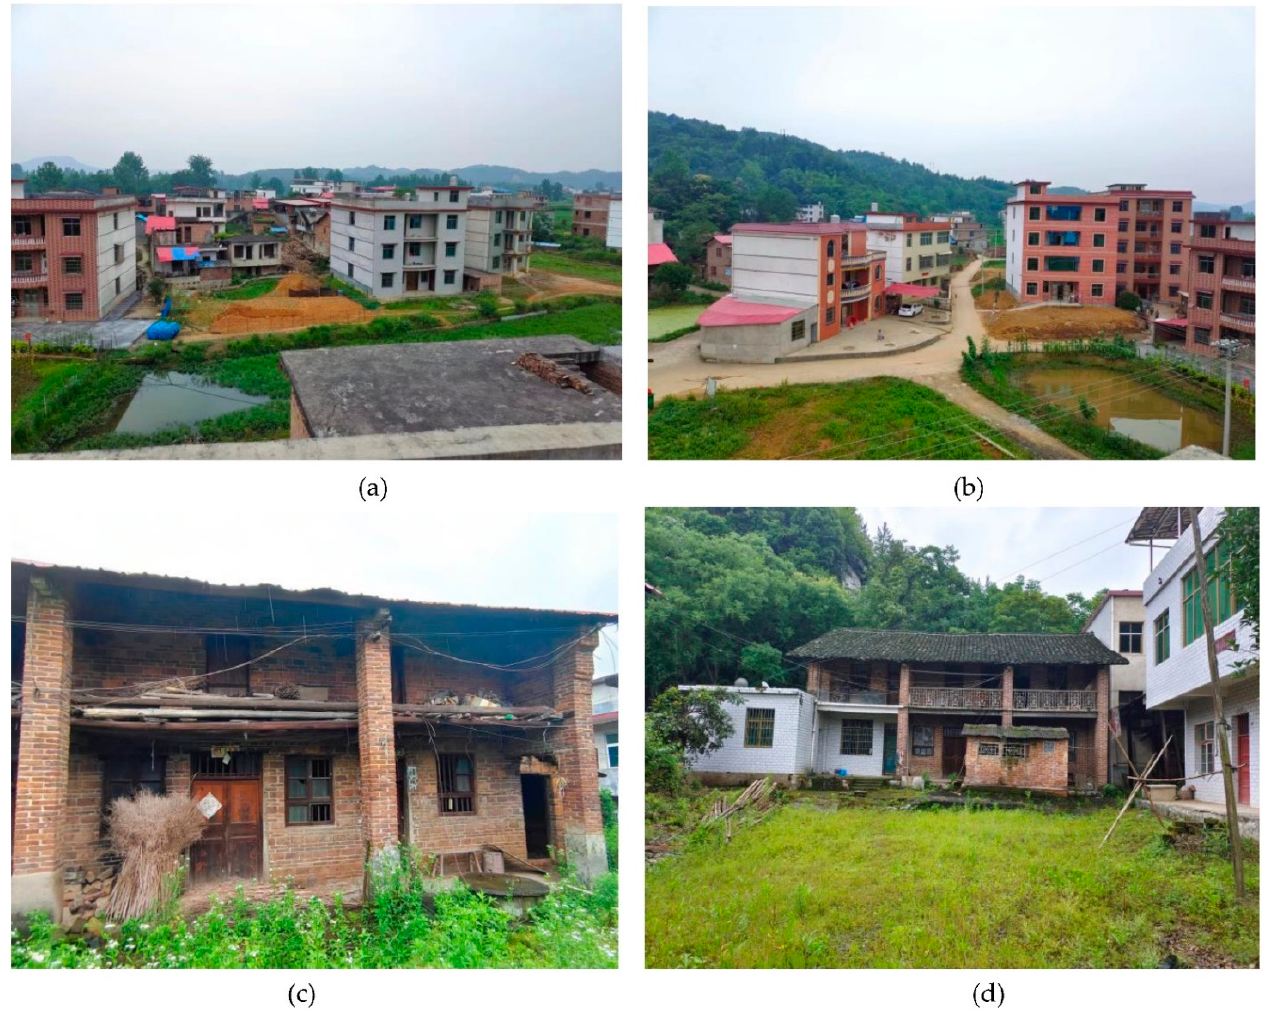
Figure 5. Idle farmhouses in Meizhou Village, Shaoyang County, Hunan Province. (Meizhou Village is a typical hollow village with a serious loss of young and middle-aged labour. Due to the lack of industrial support, the local economic development is backward. In order to make a living, people can only go out to work to obtain income, which also leads to serious problems for local left-behind children and left-behind elderly people. The contents shown in ( a , b ) in Figure 5 are that the local farmers used all the savings saved by migrant workers to build new houses on the outskirts of the village and near the roads; ( c , d ) show the contents of After local farmers built new houses, they were left idle for a long time, resulting in a waste of land resources. The pictures were taken by our co-author, Lei